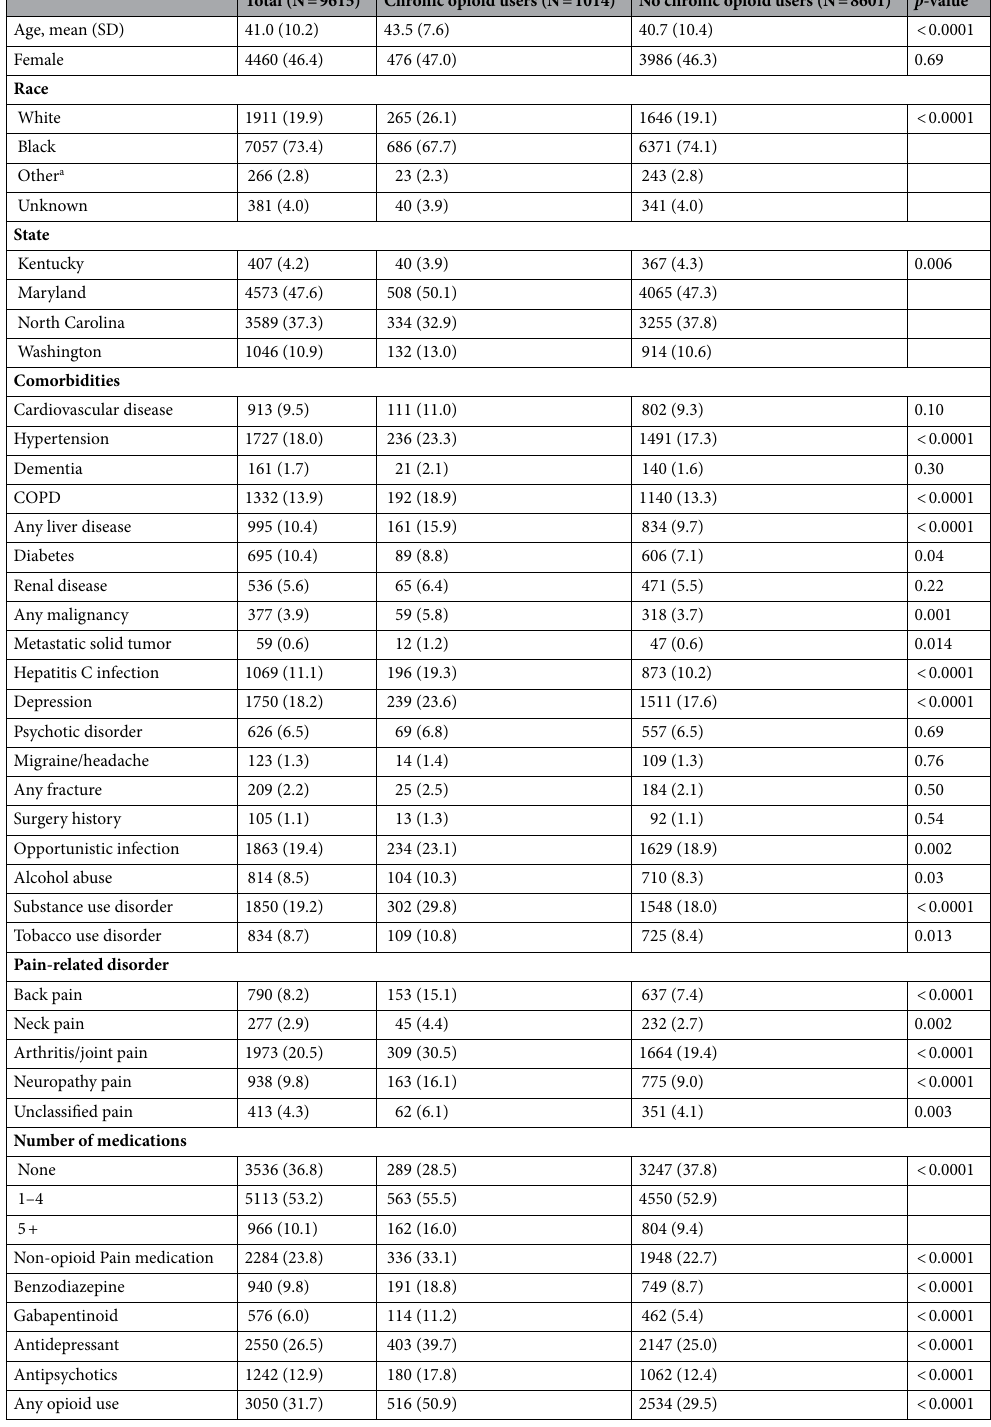
Table 1. Characteristics of study sample. Abbreviation: COPD, Chronic pulmonary disease; COT, Chronic opioid therapy. All results presented are N (%) unless otherwise noted. a American Indian, Alaskan Native, Hispanic, Asian, Pacific Islander, Native Hawaiian, more than one